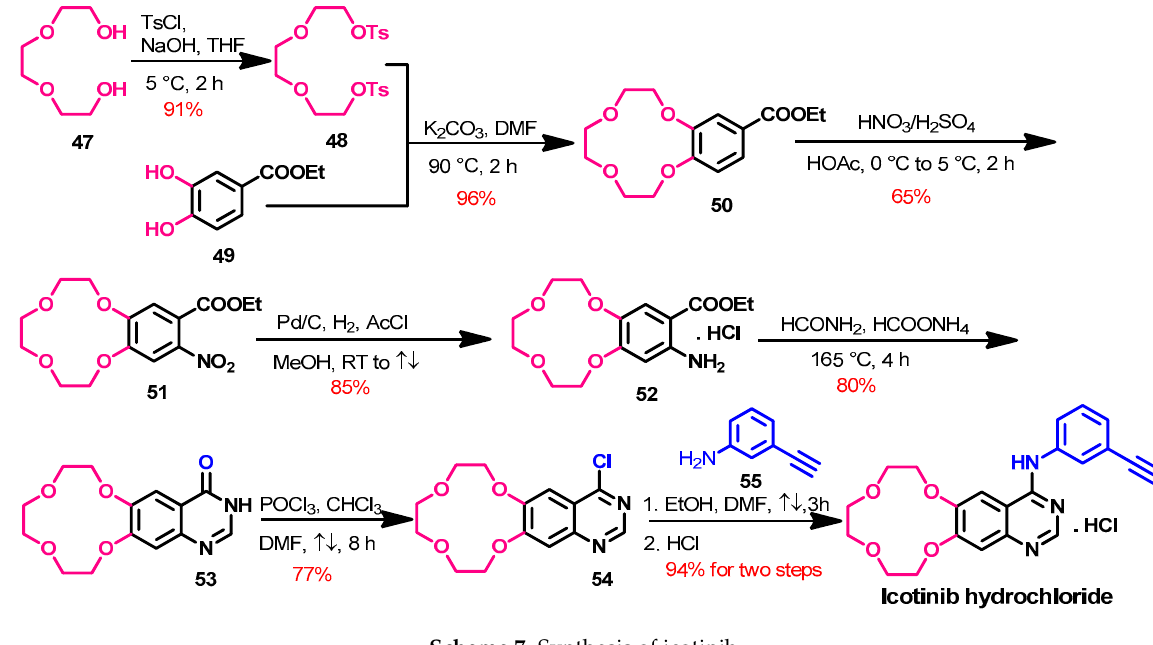
Figure 36. Chemical structure/name/synonyms of icotinib.